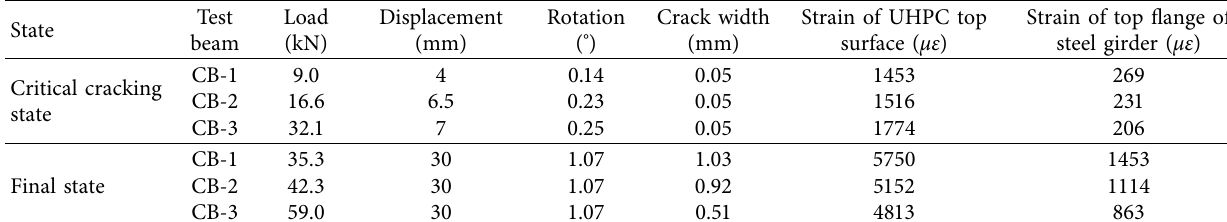
Figure 2: Layout of the test instruments: (a) deflection gauges and (b) strain gauges on the UHPC slab (units: mm). Table 4: Main test